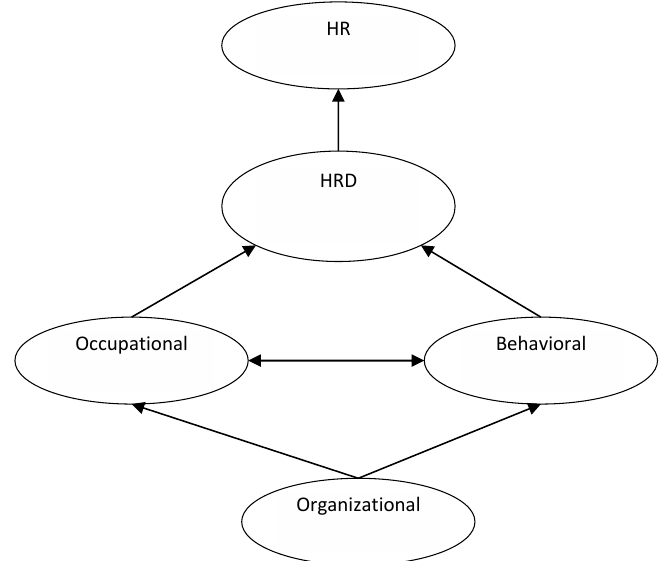
Fig. 3. The interpretive-structural model of HRD components model for SOE